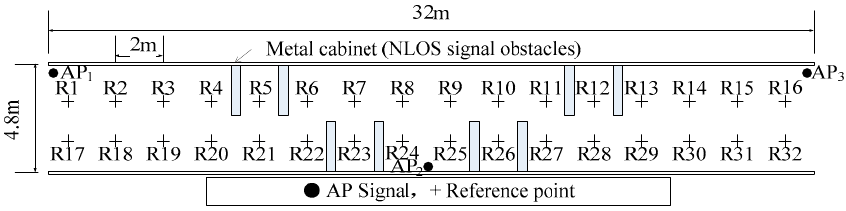
Figure 10. Plan of tunnel with non-line of sight (NLOS) signal obstacles.